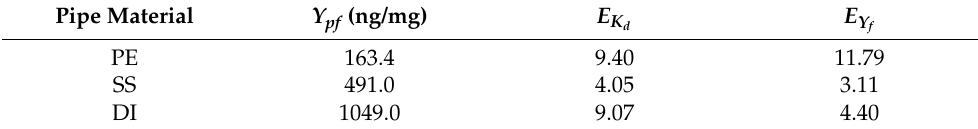
Table 2. Estimated values of pipe-material-dependent yield coefficient and temperature coefficients.